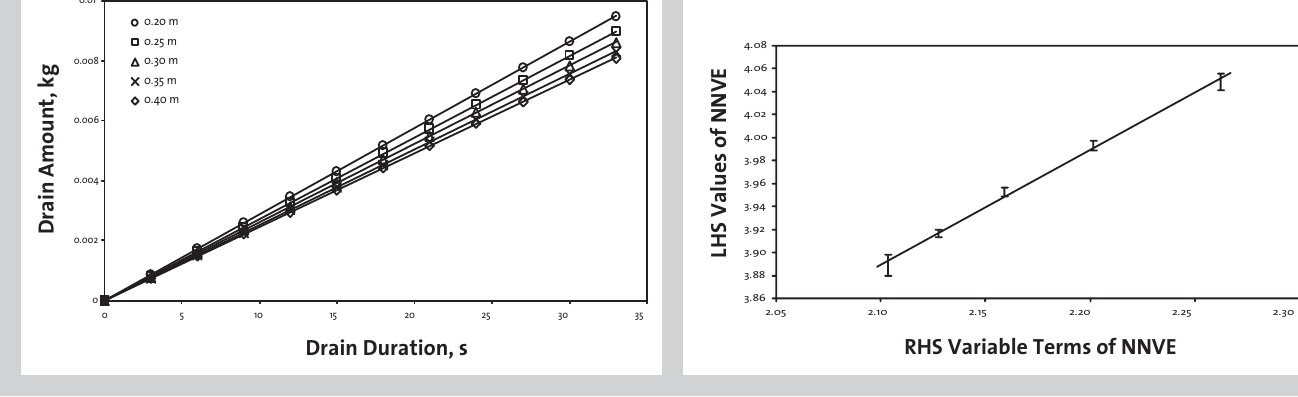
Fig. 4. The average LHS values of the NNVE and